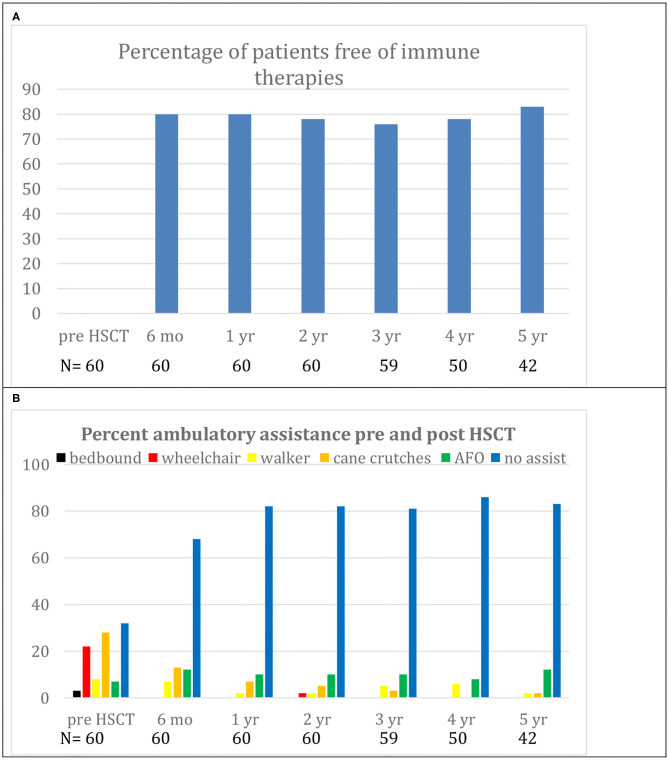
(A) Demonstrates freedom from immunological therapies for up to 5 years after hematopoietic stem cell transplantation (HSCT). (B) Demonstrates reduction in use of ambulatory aids for up to 5 years after HSCT. Replicated with permission from source (16).